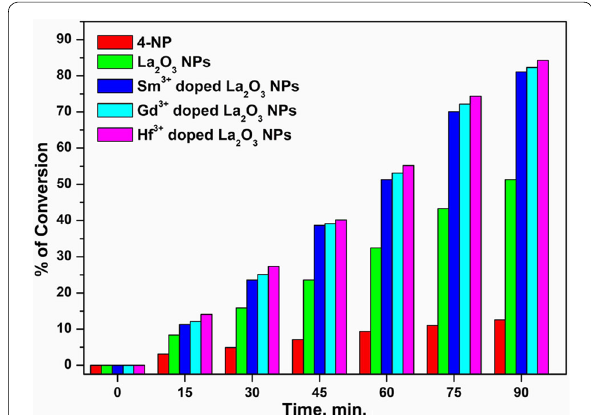
Fig. 7 UV-Vis spectra of 4-NP reduction with undoped and doped La 2 O 3 NPs at final time (90 min)